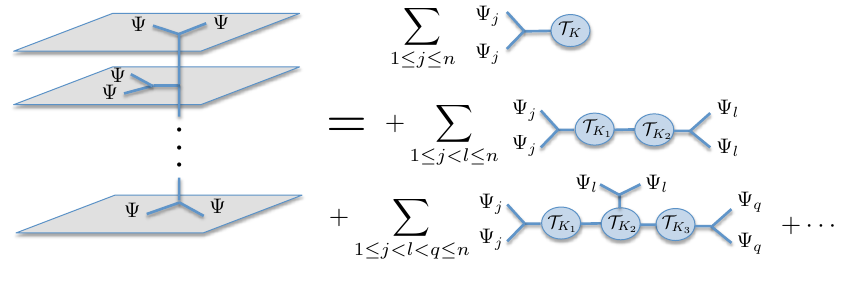
Figure 3 . Renyi entropies correspond to 2 n -point function of the operator that creates the